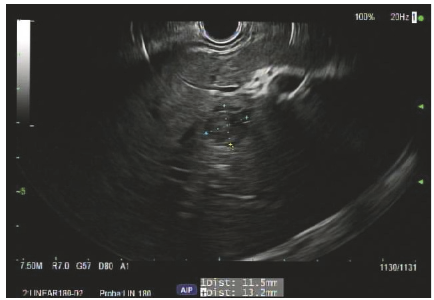
Figure 1: CTof abdomenshowing 8.1 cm heterogeneousleft adrenal mass.